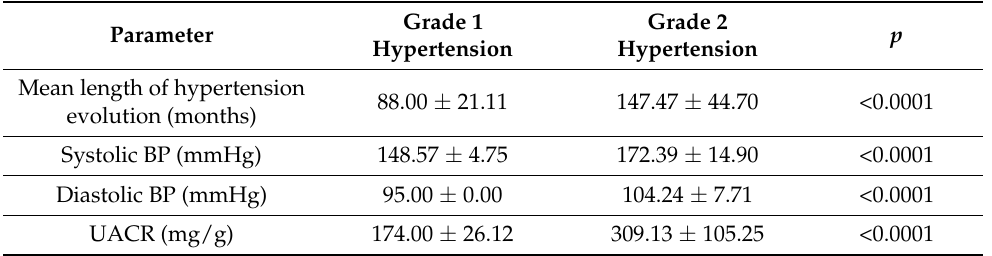
Table 3. Monitorized parameters in HN patients depending on the severity of